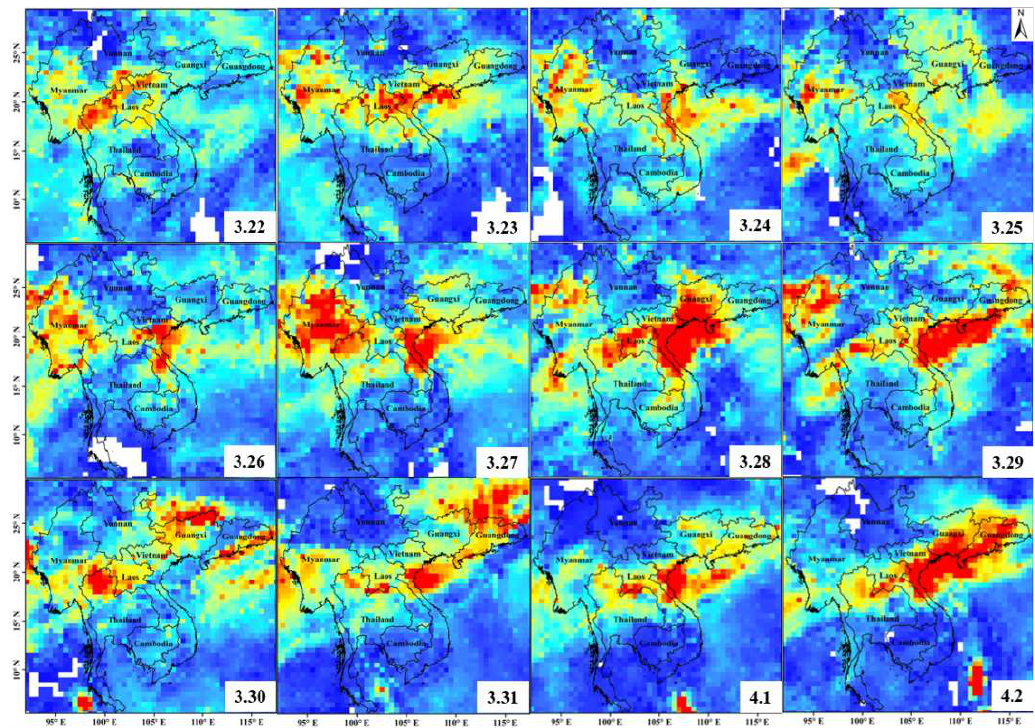
Figure 6. UVAI distribution on OMPS satellite from 22 March to 2 April 2021. (The number in the upper-right corner represents the date.)